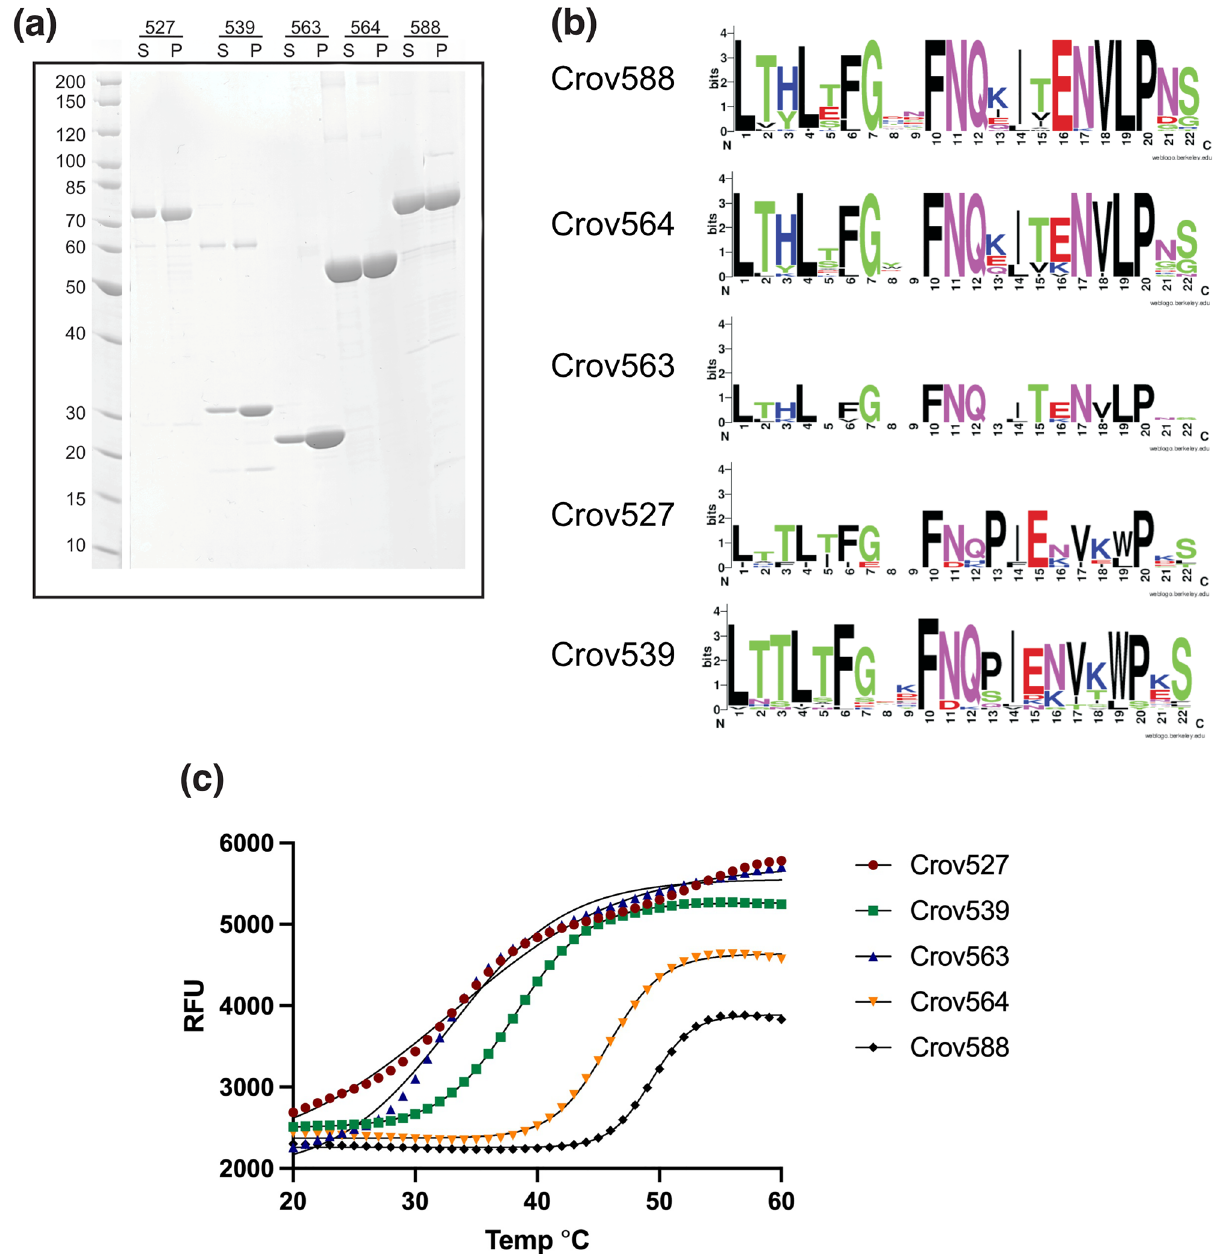
Figure 1. Properties of selected FGxxFN LRR proteins from Cafeteria roenbergensis virus. ( a ) SDS gel depicting soluble (S) and pellet (P) fractions in a heat stability assay, following heat denaturation at 97 °C for 5 min. ( b ) Logo plots of the corresponding 22-residue FGxxFN repeats. See supplementary sequence file for a comprehensive repeat annotation for all ~ 70 Crov FGxxNN repeat proteins. ( c ) Thermofluor measurements of unfolding. Calculated V50 melting temperature values are: Crov527 Tm 30.1 °C, Crov539 Tm 38.2 °C, Crov563 Tm 32.9 °C, Crov564 Tm 45.8 °C, Crov588 Tm 49.3